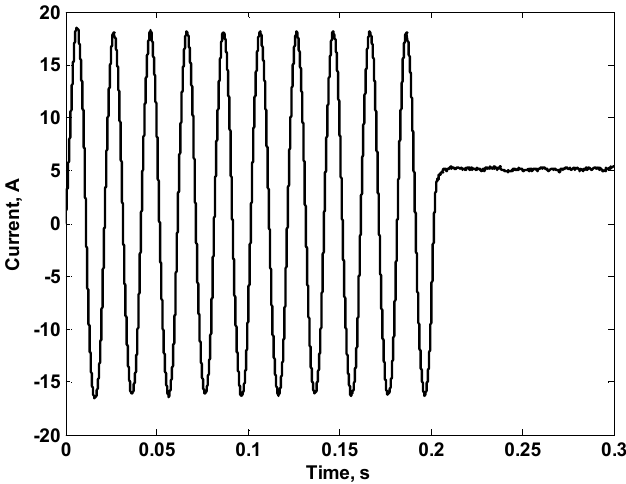
Figure 16. Output Current with +ve DC transfer at Converter Terminals.